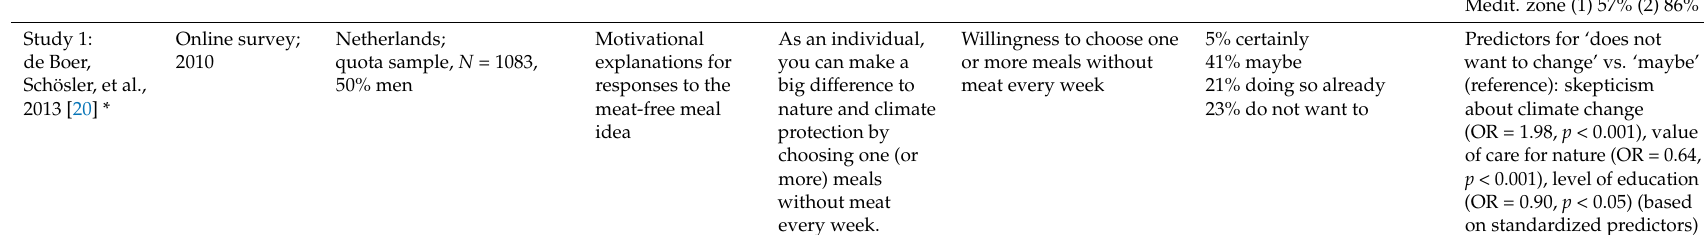
Outcome Measure: Willingness to